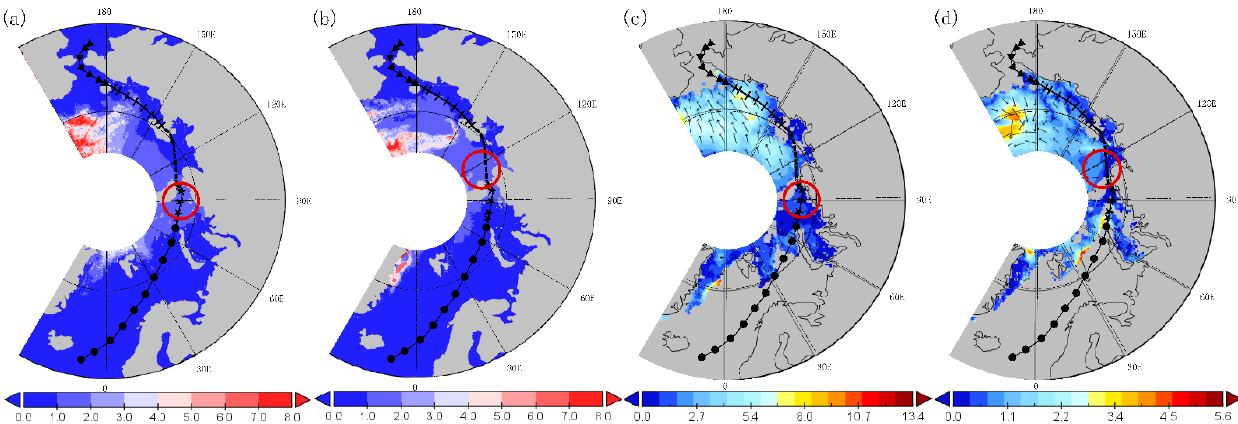
Figure 10. The distribution map of sea ice age in the NEP in the Arctic summer in 2003 ( a ) and 2004 ( b ), and the map of sea ice movement in the NEP in the Arctic summer in 2003 ( c ) and 2004 ( d ).